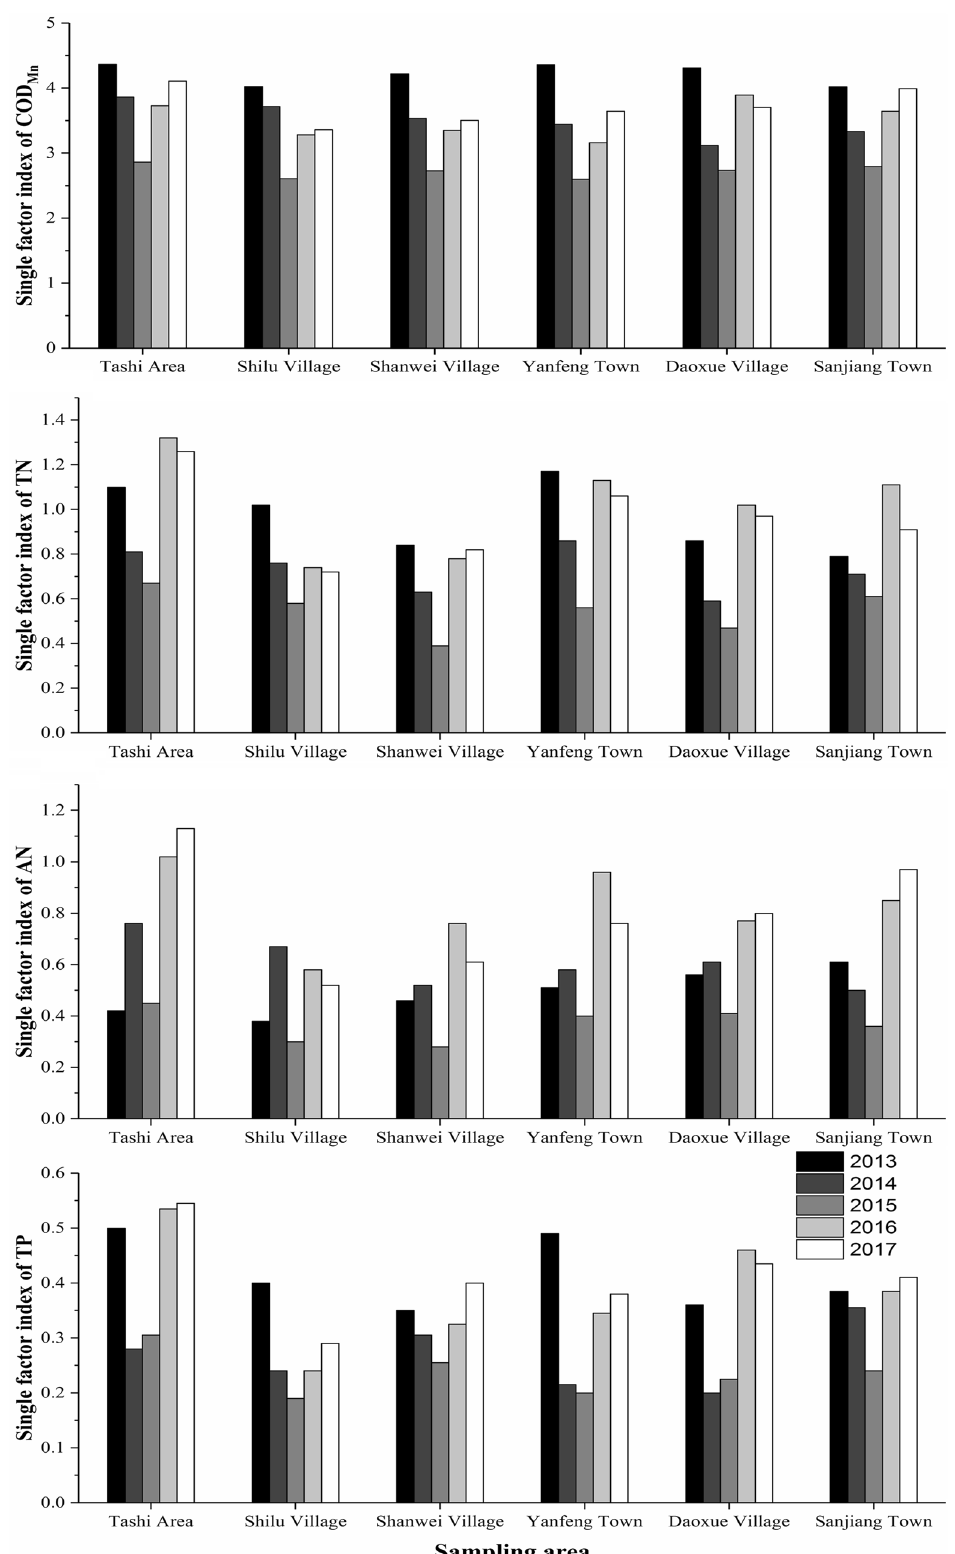
Fig. 4 Single factor indices of six regions from 2013 to 2017 (COD